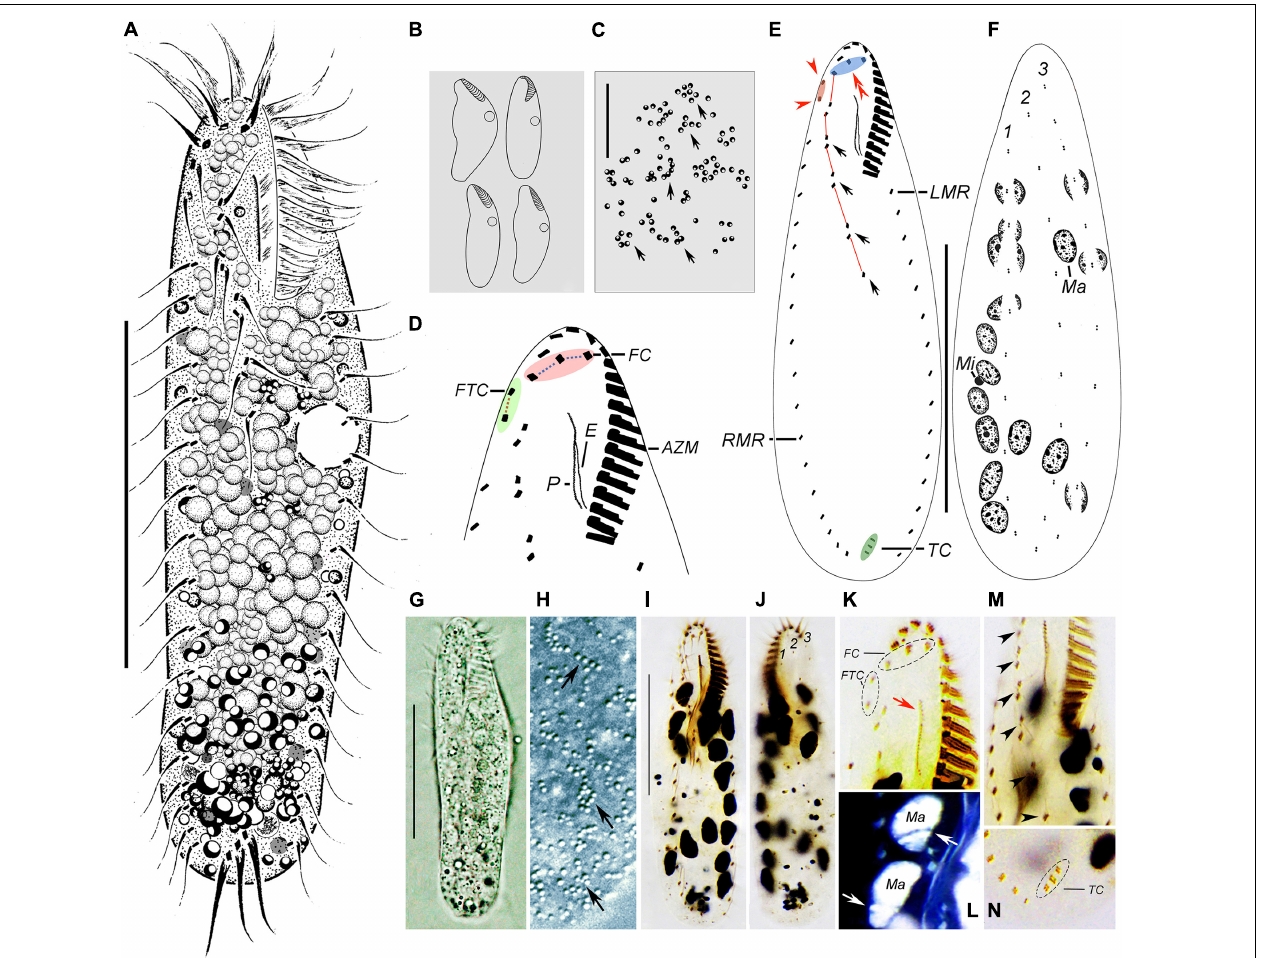
FIGURE 3 | Morphology of Wilbertophrya sinica n. sp. from life (A–C,G,H) and after staining with protargol (D–F,I–N) . (A) Ventral view of a representative individual. (B) Ventral views to show different body shapes. (C) Arrangement of cortical granules on dorsal side (arrows). (D) Ventral view to demonstrate ciliature in frontoventral area. (E,F) Ventral (E) and dorsal (F) views showing the infraciliature. Arrows mark midventral pairs, arrowheads point to frontoterminal cirri, and double arrowheads indicate frontal cirri. (G) Ventral view. (H) Arrangement of cortical granules (arrows) on dorsal side. (I) Ventral view of the holotype specimen to show ventral ciliature. (J) Dorsal view to show dorsal kineties and macronuclear nodules. (K) Ventral view of anterior portion to show the frontal and frontoterminal cirri, endoral, and paroral (arrow). (L) Dorsal view to show macronuclear nodules and replication bands (arrows) (the color of image was inverted using Photoshop). (M) Ventral view to show the midventral pairs (arrowheads). (N) Ventral view of posterior end showing transverse cirri. AZM, adoral zone of membranelles; CV, contractile vacuoles; E, endoral; FC, frontal cirri; FTC, frontoterminal cirri; LMR, left marginal row; Ma, macronucleus nodules; Mi, micronuclei; P, paroral; RMR, right marginal row; TC, transverse cirri; 1–3, dorsal kineties 1–3. Scale bars: (A,E,F,G,I) = 40 µ m, (C) = 15 µ